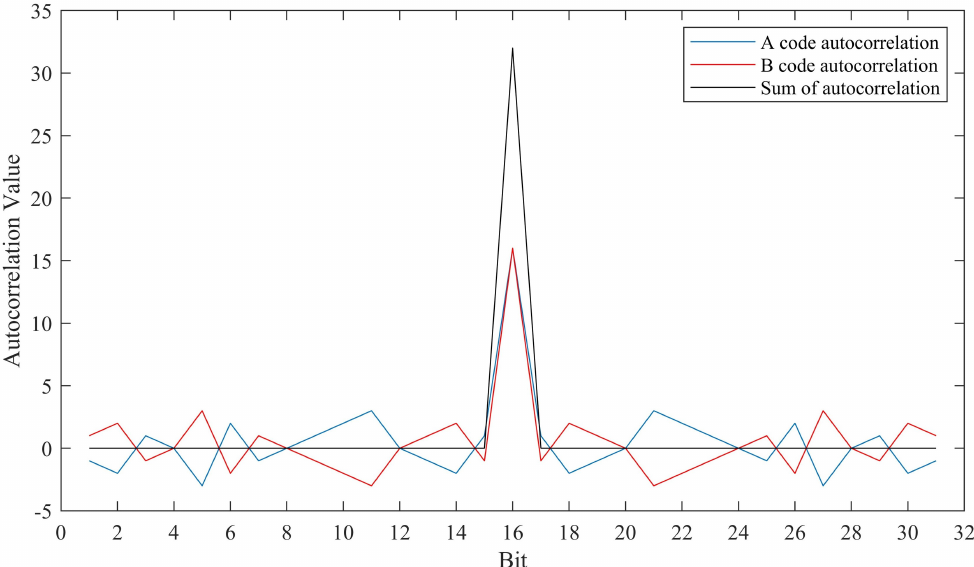
Figure 1. Autocorrelation processing results of complementary codes and sum result of two autocor- relation